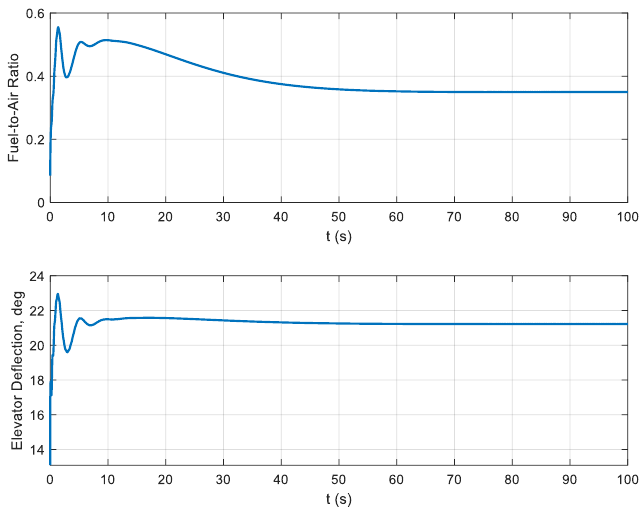
Figure 3. Input of the plant.